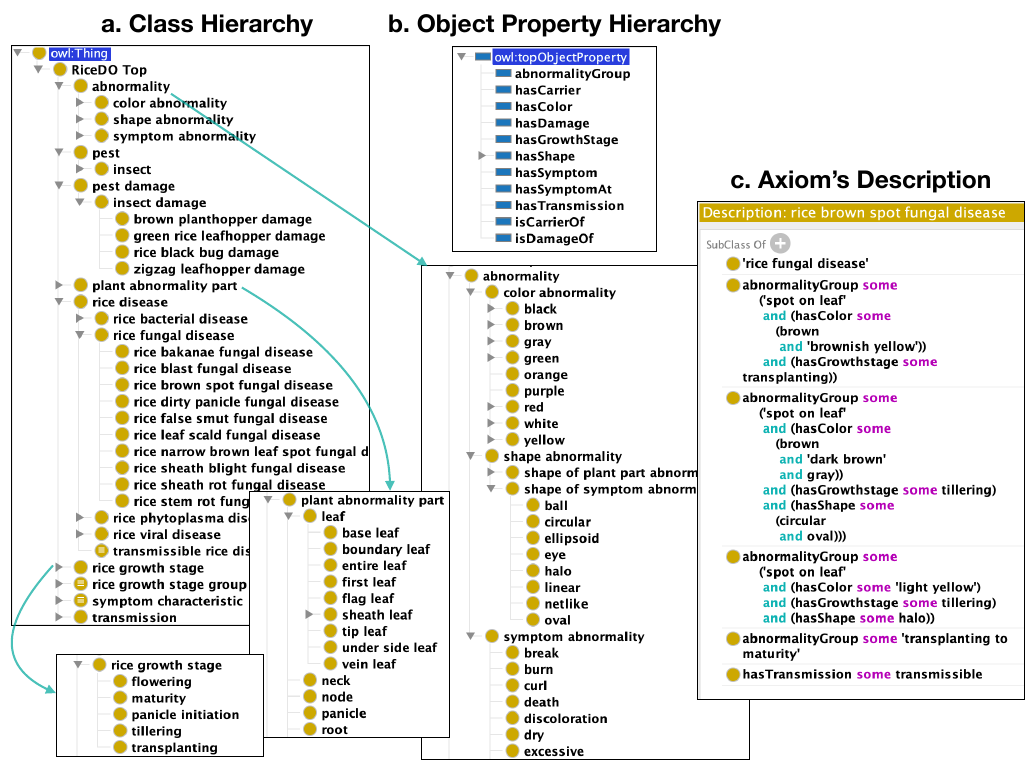
Figure 1. The structure of RiceDO ontology is divided into three parts: ( a ) the class hierarchy of RiceDO; ( b ) the object properties of RiceDO; and ( c ) an example of axioms representing abnormalities of the rice brown spot fungal